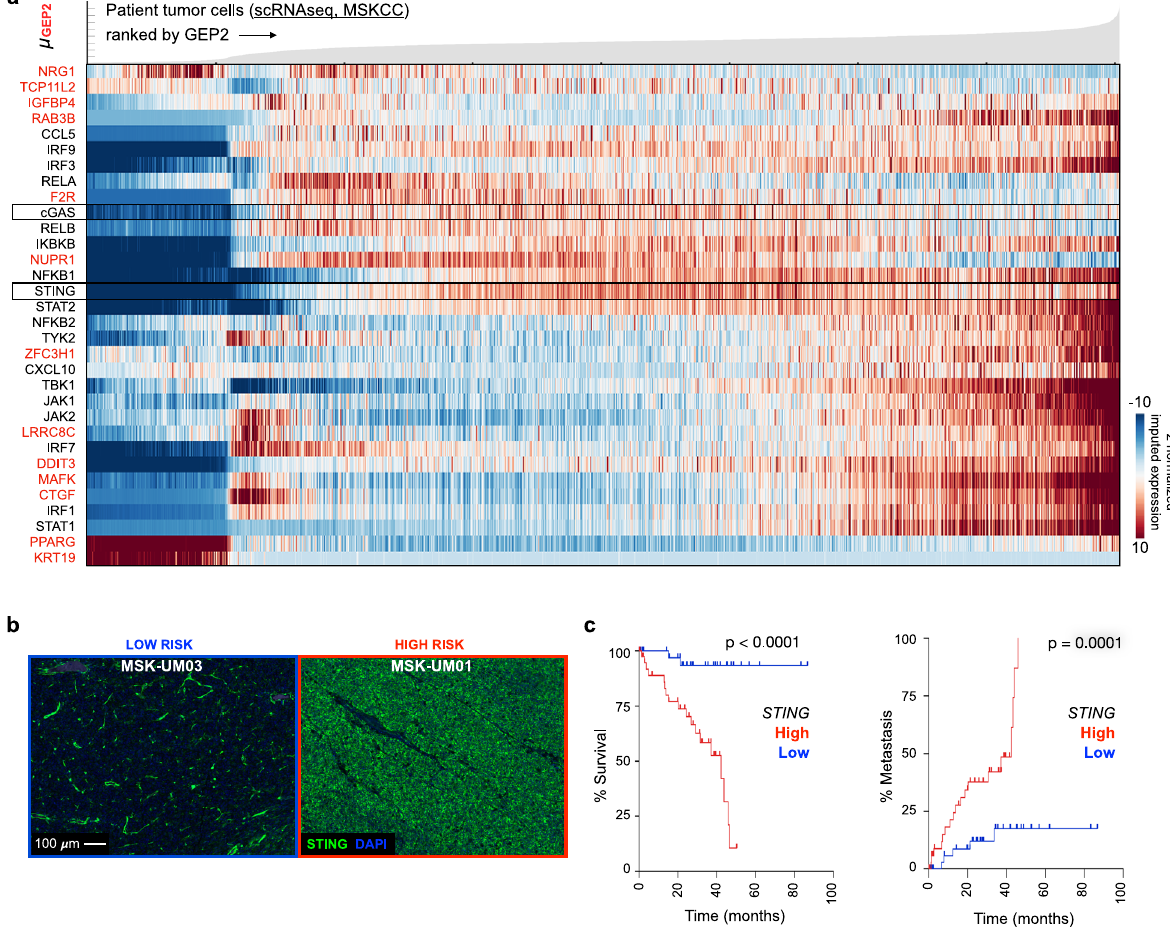
Fig. 7 Cell-intrinsic in fl ammation in high-risk UM. a Expression of key cytosolic nucleic acids sensors, intermediate signaling adapters, executioners, interferon stimulated genes (ISGs) and CIN-induced non-canonical NF-kB targets (shown in red) 56 for all patient tumor cells ranked by average imputed expression of the GEP2 gene signature (gene signatures annotated in Supplementary Data File 1) in ascending order from left to right; genes are clustered using an Euclidean distance metric. For each gene, imputed expression was z-normalized across all cells and smoothed using a 20-cell moving average window. Top, fi lled area plot showing average expression of the GEP2 signature across ranked tumor cells. b Immuno fl uorescence of STING (green) and DAPI (blue) in MSK-UM03 (greatest proportion of GEP1 tumor cells in the cohort) and MSK-UM01 (greatest proportion of GEP2 tumor cells in the cohort). Representative images from six biological specimens. c Overall survival (left) and UM-related metastasis (right) of ( n = 80) TCGA-UM patients with primary tumors strati fi ed by expression of high (top 50th percentile, n = 40) and low (bottom 50th percentile, n = 40) STING . Statistical signi fi cance tested using two-sided log-rank test; p (left) = 2.2 × 10 − 5